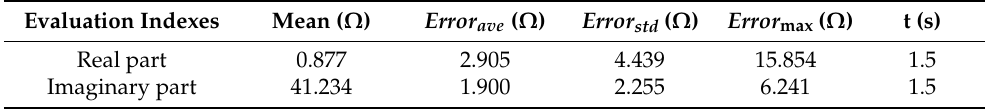
Table 9. Evaluation indexes of method 2 in 7th harmonic.